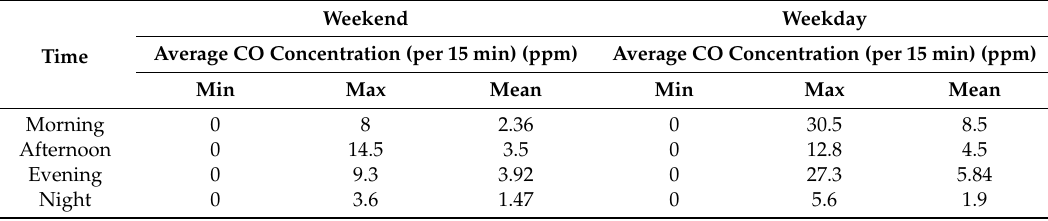
Table 2. Summary statistics of traffic CO